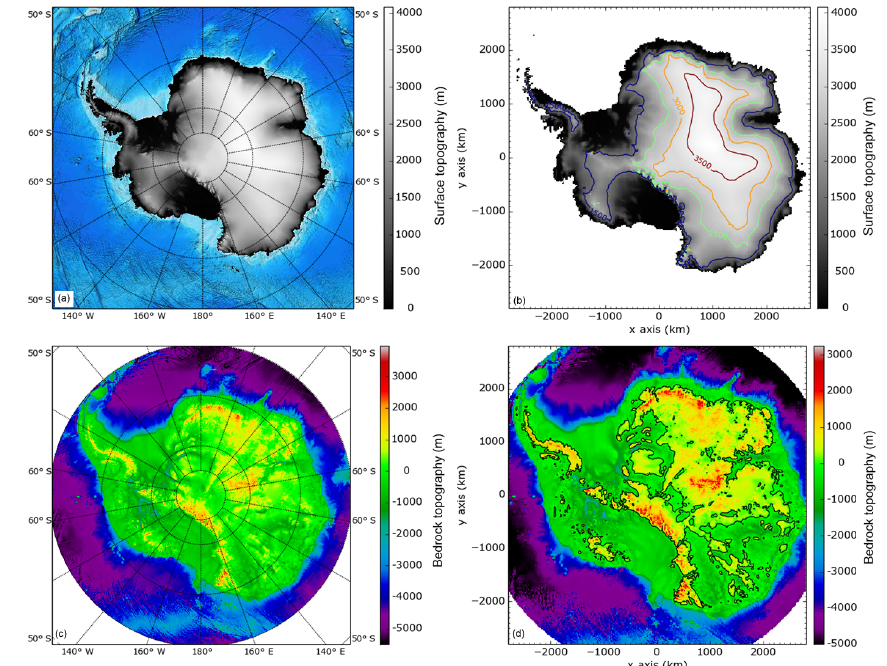
Figure 9. As in Fig. 7 but for Antarctica; the Antarctic ISM grid resolution in (b, d) is 20km × 20km.